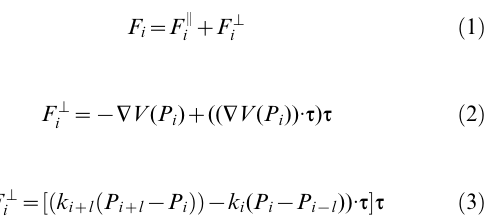
Figure S2 Comparison of conservation scores for residues in the allosteric and substrate ATP-binding sites and surface in the UMP kinase family. The statistical significant ( P -value) was calculated by the Mann-Whitney U test. (TIF) Figure S3 The time-dependences of C a atoms RMSD of UMP kinase, temperature, total energy, mass density, and volume during 100 ns MD simulations. The interaction energies between UMP kinase and ATP were calculated every 10 ns interval trajectories. The error bars represent standard deviations. (TIF) Figure S4 The allosteirc trigger of the adenine in ATP in the P2X 4 ion channel (A) and the triphosphate in ATP in the glycogen phosphorylase (B). The structural features and color scheme follow the description in Figure 7. The functional sites for TM1 and TM2 of the P2X 4 ion channel and the gate (residues 280–289) of the glycogen phosphorylase are highlighted. (TIF) Figure S5 The locations of the allosteric ATP-binding sites in the aspartate carbamoyltransferase. Table S1 Sequence identity (%) between the 13 allosteric proteins. Table S2 Root-mean-square deviation (A˚ ) between the 13 allosteric proteins. Table S3 Twenty-four proteins modulated by substrate ATP. Table S4 The conservation scores for residues in the allosteric (10 residues) and substrate (22 residues) ATP-binding sites and surface (31 residues) in the UMP kinase family. Table S5 The energy barriers (kcal/mol) of ATP access to allosteric and substrate binding sites for each NEB simulation. Table S6 Proteins allosterically modulated by ATP deposited in ASD v2.0. Table S7 Summary of MD simulation systems. Table S8 Simulated annealing protocol used for minimization in NEB